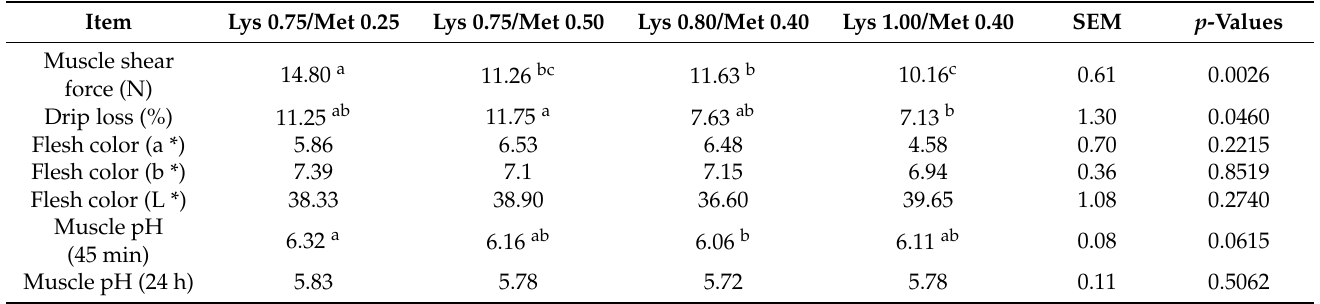
Table 4. Effect of different lysine and methionine composition in diets on muscle quality in rabbits ( n =